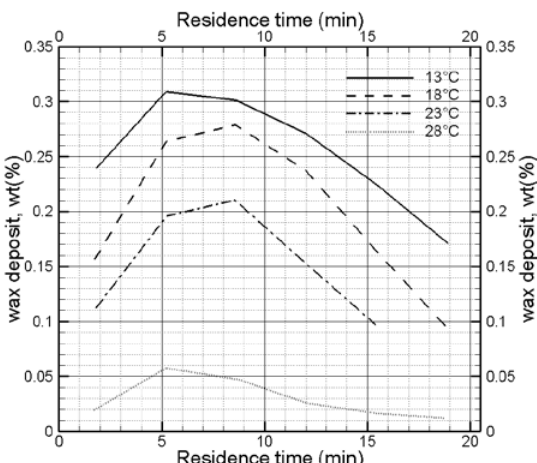
Figure 16 Effect on wax deposition due to residence time at 400 ml/min (Kelechukwu et al., 2010)